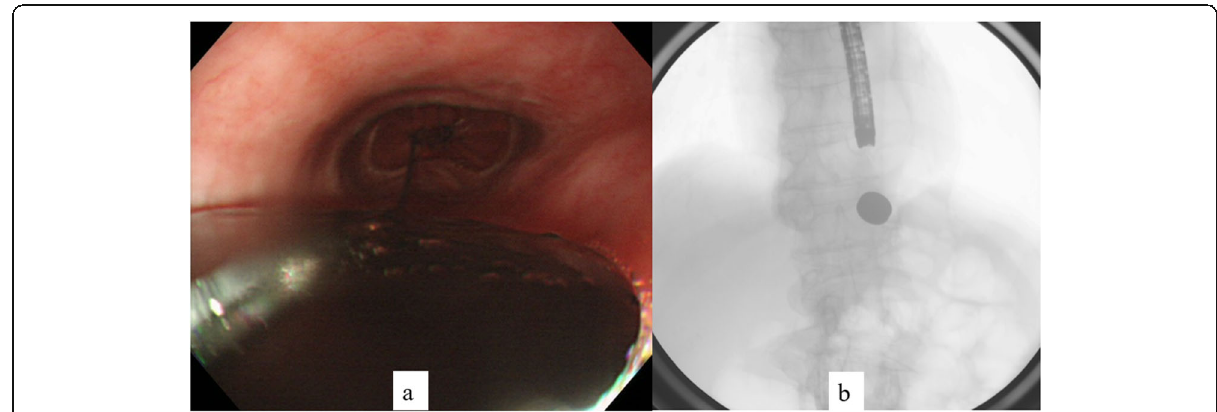
Fig. 3 Magnetic compression anastomosis (placing the parent magnet on the anal side of the stenosis). a Esophagogastroduodenoscopy. b